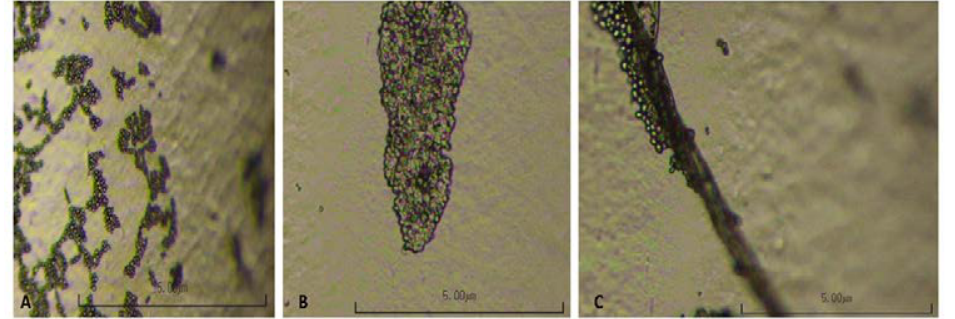
Fig. 1. Candida albicans biofilms on PVC-ETT at (A) 24 h, (B) 48 h, and (C) 72 h under light microscope at high power objective.